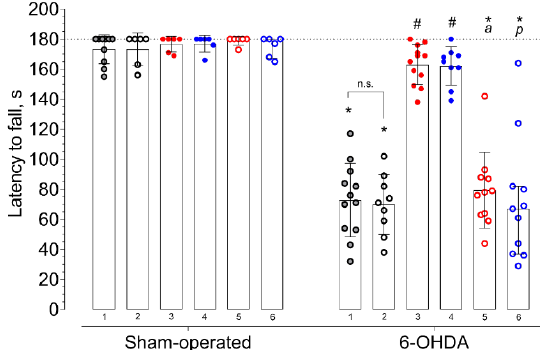
Figure 5. The influence of deferred administration of afobazole over 14 days on latency to fall during accelerated rotarod test (ARR) in 6-OHDA-lesioned and sham-operated ICR mice. Data are presented as median with interquartile range. Sham-operated—sham-operated animals. 6-OHDA—animals with 6-OHDA lesion. Experimental groups were divided by treatment, drugs were administered 20 h prior to the test: 1 vehicle. 2 BD-1047 3.0 mg / kg. 3 afobazole 2.5 mg / kg. 4 PRE-084 1.0 mg / kg. 5 BD-1047 3.0 mg / kg and afobazole 2.5 mg / kg. 6 BD-1047 3.0 mg / kg and PRE-084 1.0 mg / kg. Kruskal-Wallis test, Dunn’s multiple comparison test: A significant di ff erence ( p < 0.05) was observed within all experimental groups except for afobazole (3) and PRE-084 (4). Statistical significance: * p < 0.01 vs. sham-operated vehicle-treated mice. # p < 0.05 vs. 6-OHDA-lesioned vehicle-treated mice. a p < 0.01 vs. 6-OHDA-lesioned afobazole-treated mice. p p < 0.05 vs. 6-OHDA-lesioned PRE-084-treated mice. n.s. —no statistical significance between compared